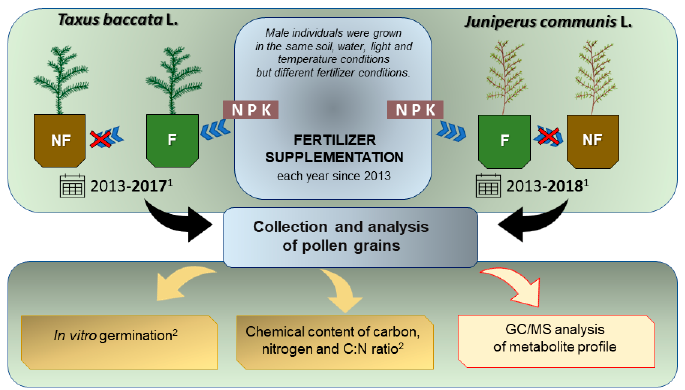
Figure 8. Experimental design. 1—year of pollen grains collection; 2—data were presented in Pers-Kamczyc et al. [11,12].